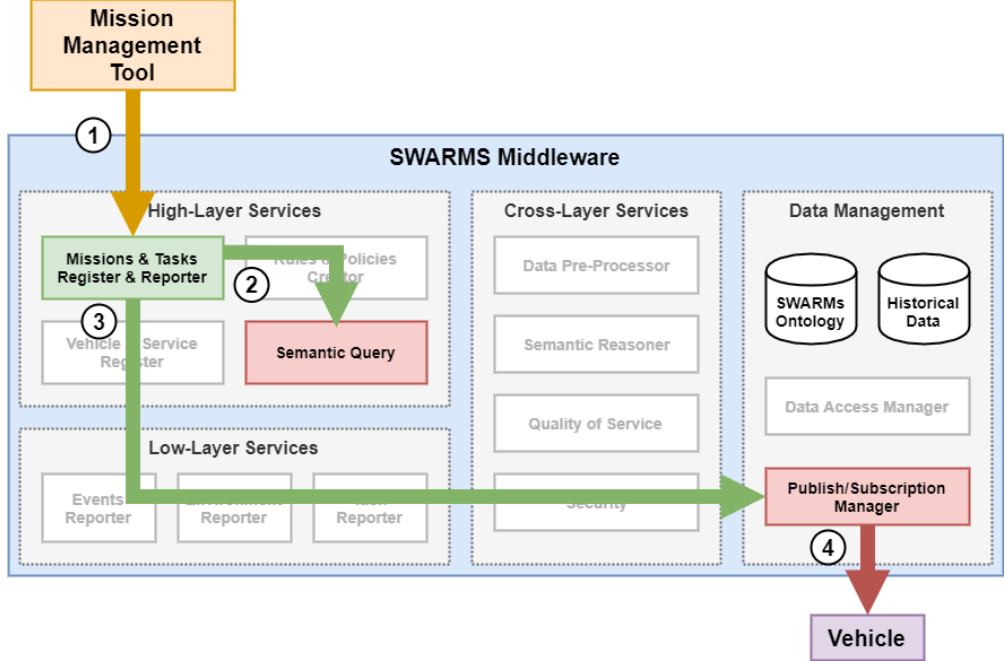
Figure 9. Functional overview of the start of a mission.